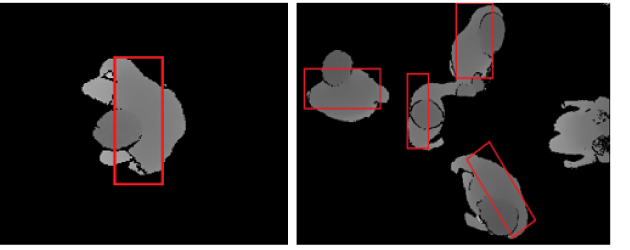
Figure 4. Results obtained for shoulder detection using joint the HOG symmetry technique over the GOTPD